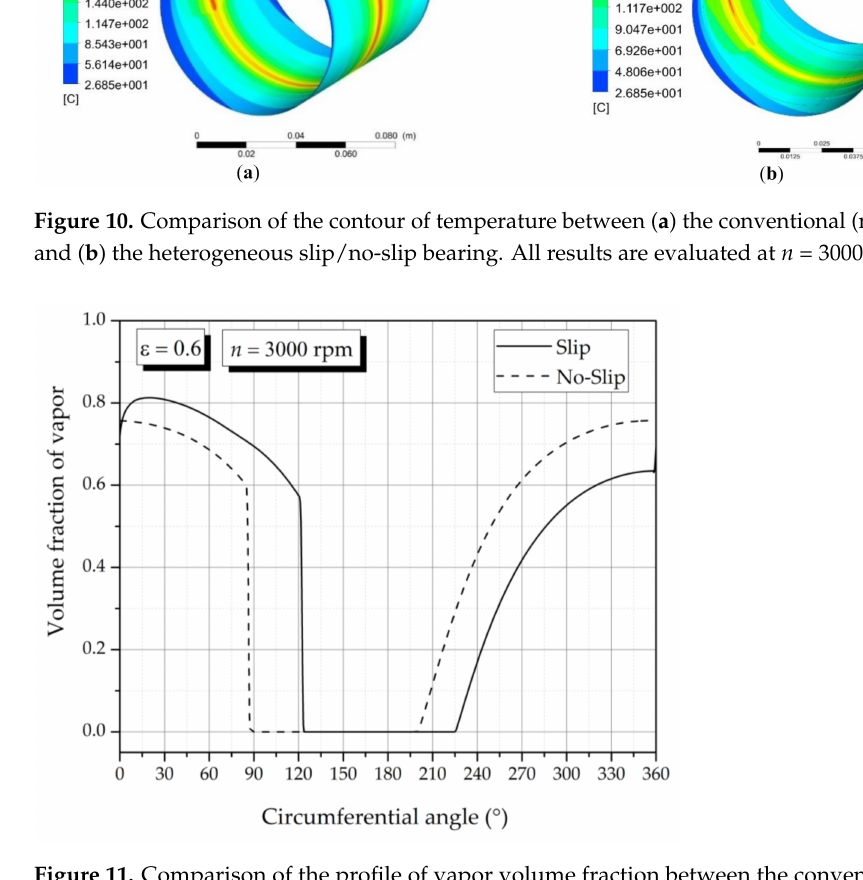
Figure 11. Comparison of the profile of vapor volume fraction between the conventional (no-slip) bearing and the heterogeneous slip/no-slip bearing. All results are evaluated at z / L = 0.5 and n = 3000